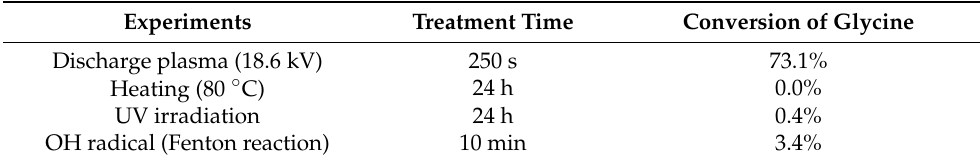
Table 1. Conversions of glycine treated by several comparative